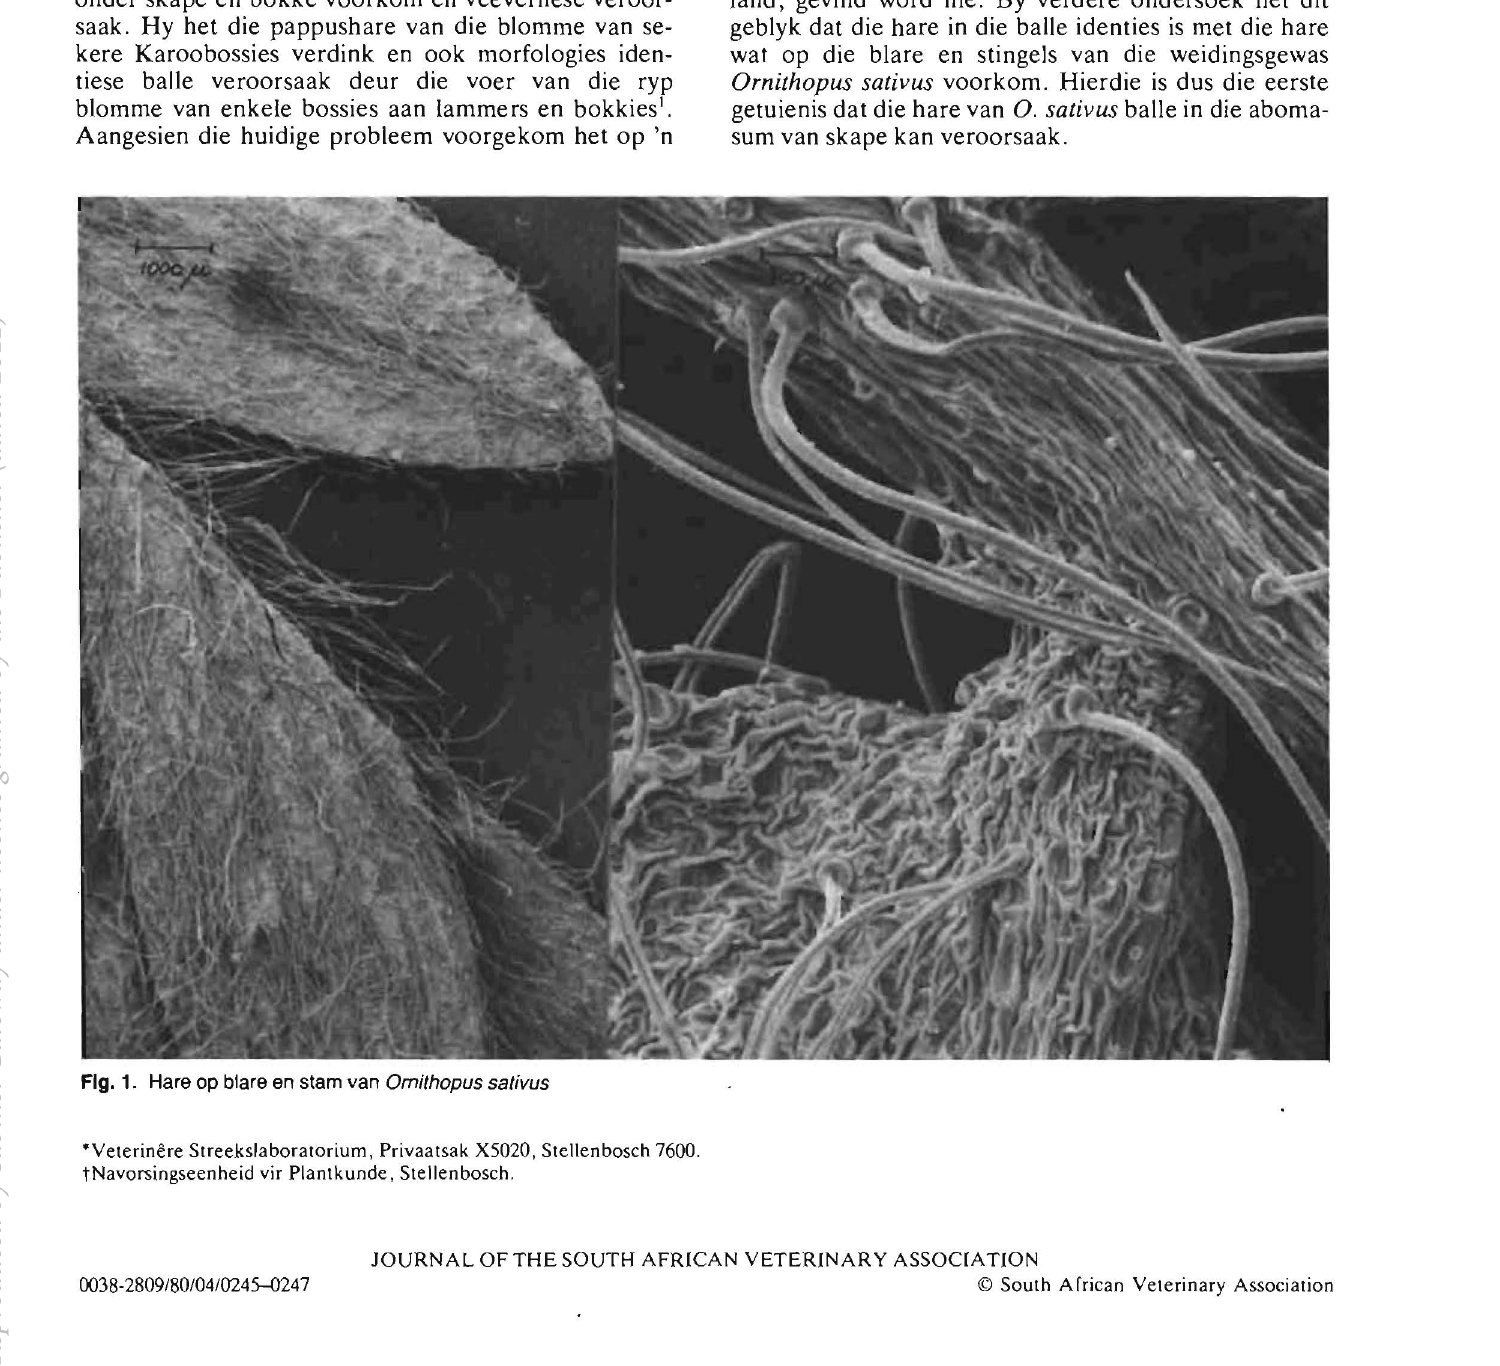
Fig. 1. Hare op blare en stam van Omithopus